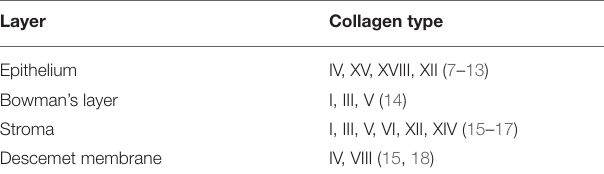
TABLE 1 | Distribution of collagen types in the human